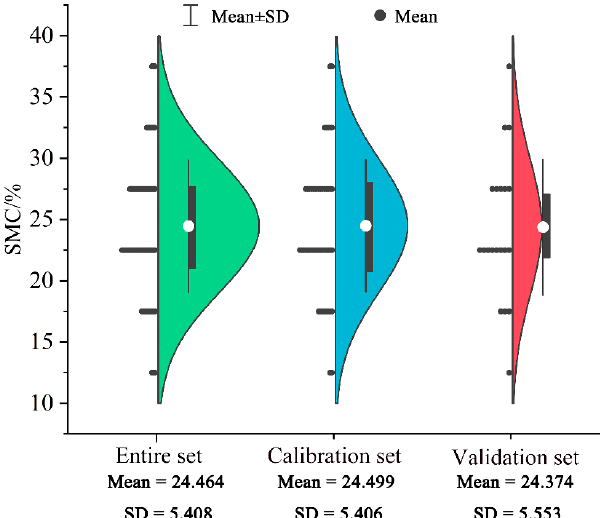
Figure 2. SMC samples and their descriptive statistics (the colored areas are the kernel density distributions of the different